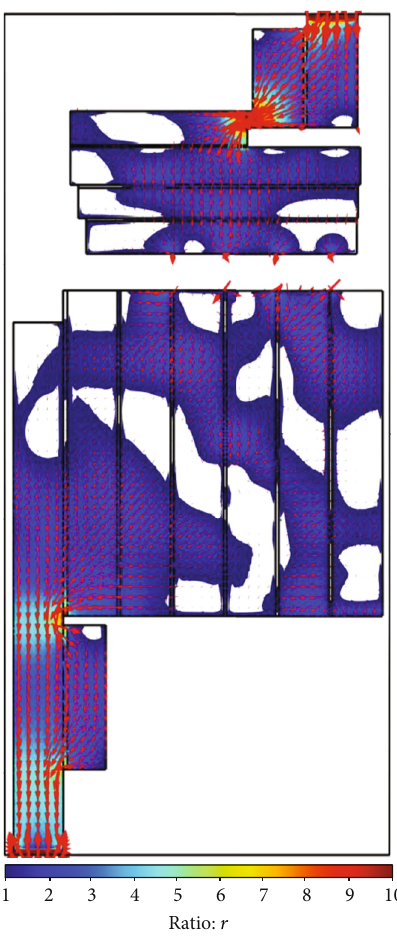
Figure 11: The r value cloud map and fl ow direction above the coal seam fl oor. (a) The range of 0 ~ 5.1m from the coal seam fl oor. (b) The range of 15 ~ 20m from the coal seam fl oor. (c) The range of 25 ~ 30m from the coal seam fl